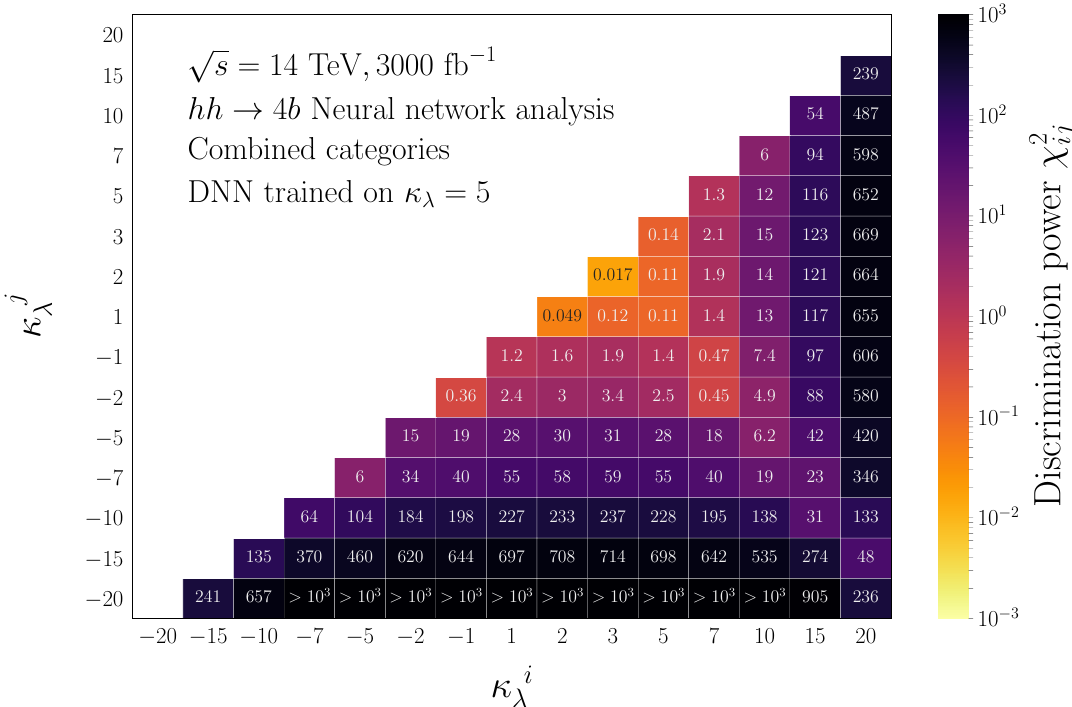
Figure 13. Discrimination power χ 2 (higher is better) between two self-coupling hypotheses λ i ij vs λ j for the neural network analysis after combining the three categories. The DNN is trained on hhh the κ λ = 5 sample, where the signal score is required to be p signal > 0 . 75 . The χ 2 eq. (3.1) assuming κ t = 1 and background systematics of ζ b = 0 . 3% , 1% and 5% for the